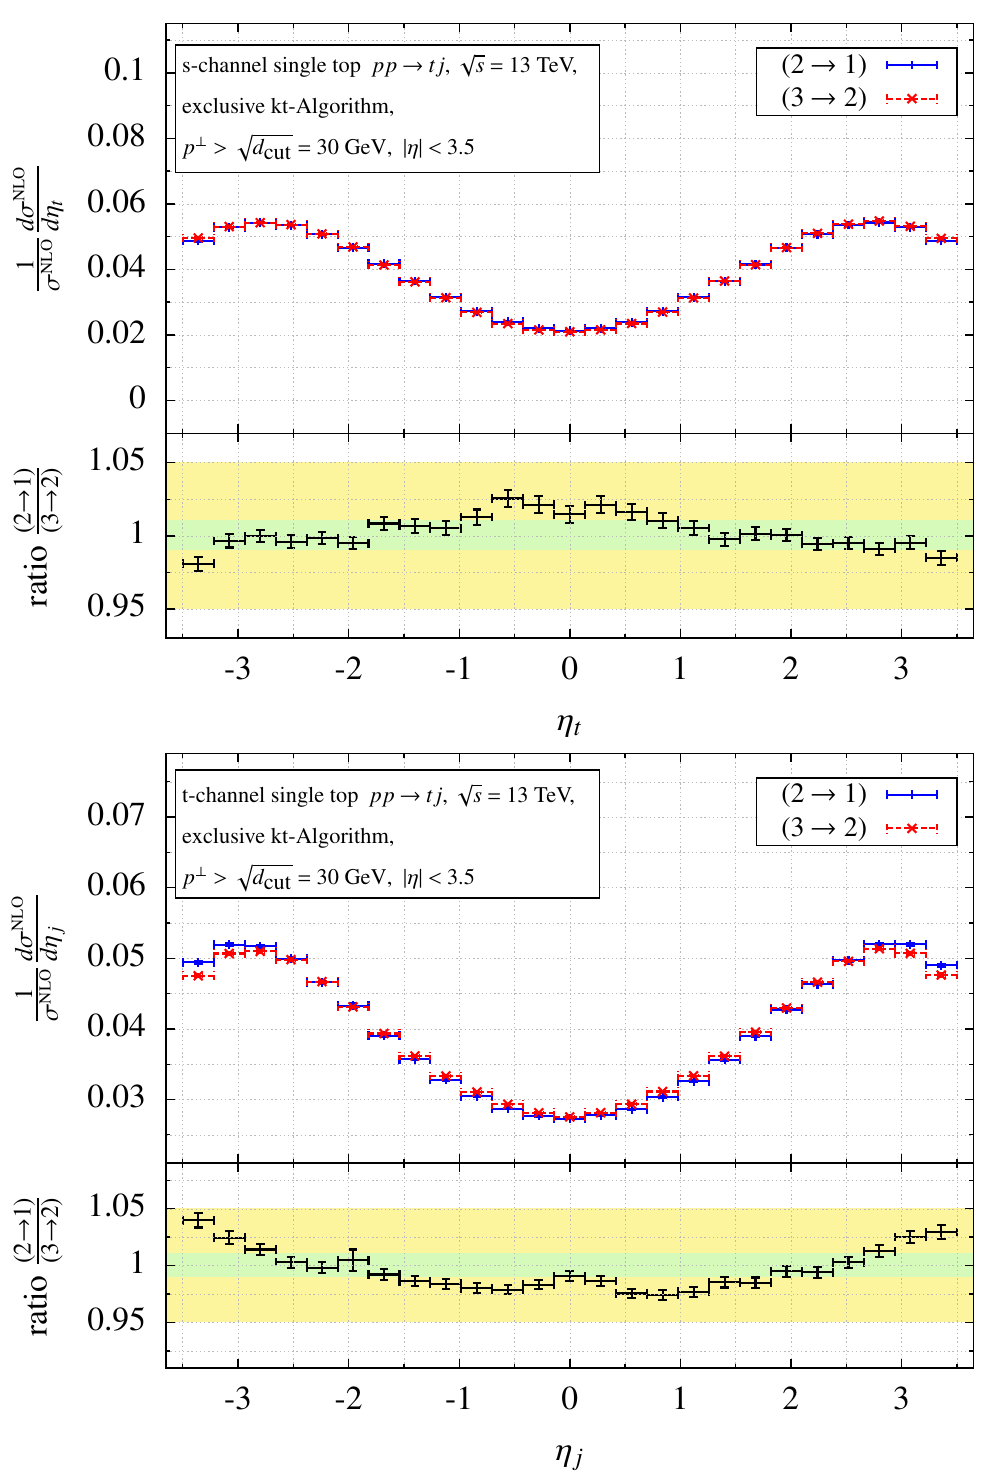
Figure 5 . Examples for pseudo rapidity distributions for the top-tagged and the light jet from s - and t -channel single top-quark production at NLO with 3 ! 2 (red, dashed) and 2 ! 1 (blue, solid) jet clusterings.